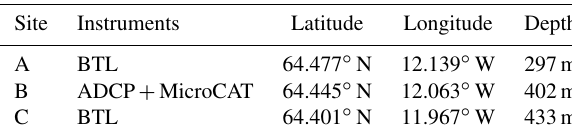
Table 1. Positions and bottom depths of the three deployment sites. BTL indicates the bottom temperature logger. All instruments were placed directly on the bottom in trawl-protected